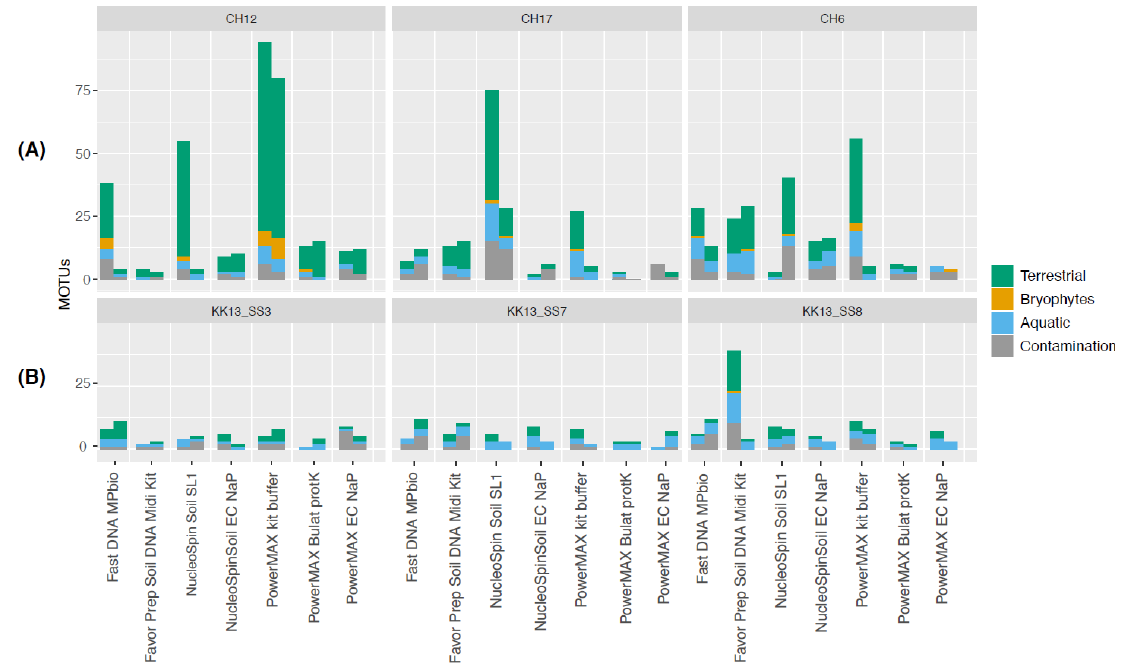
Figure A6. Number of MOTUs identified in samples of ( A ) surface sediments of lakes of the Southern Taymyr Peninsula and ( B ) Lake Karakul after extraction with a range of different protocols.